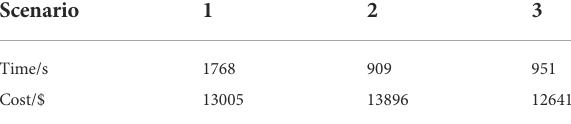
TABLE 3 Results comparison in Case